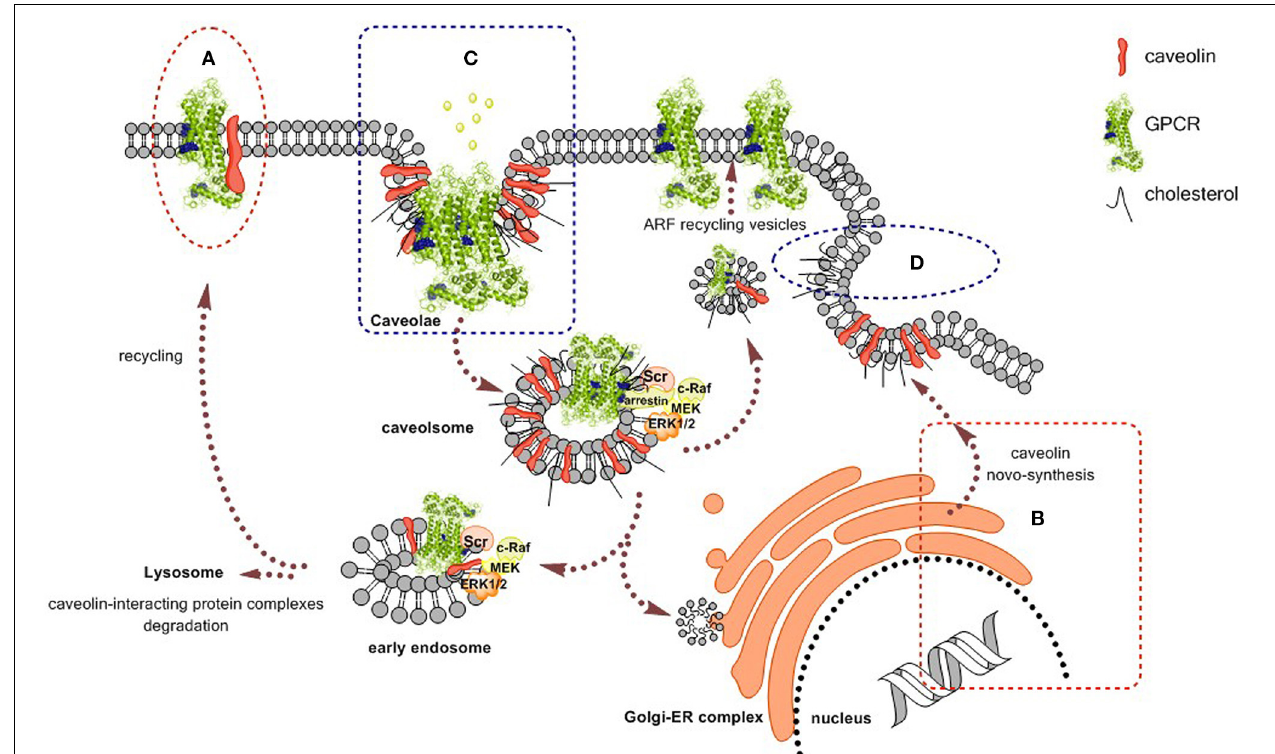
FIGURE 1 | Scheme of caveolins/caveolae participation in the cell biology of GPCRs. Caveolins/caveolae regulate agonist binding and signaling and GPCR traffic. Some interventions with therapeutic potential are: (A) targeting caveolin-binding domains in the GPCR. (B)